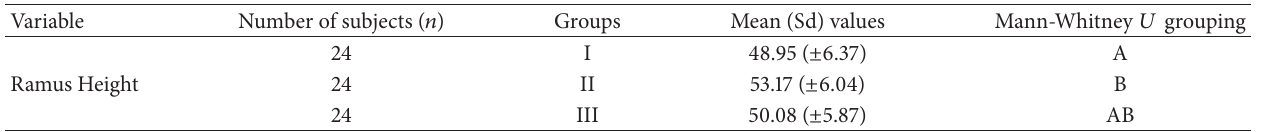
Table 3: Mean ramus height values, standard deviations, and Mann-Whitney 𝑈 test